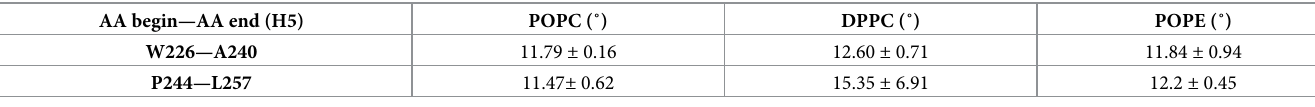
Table 6. Tilt angle of the two part of helix H5 with standard deviation.